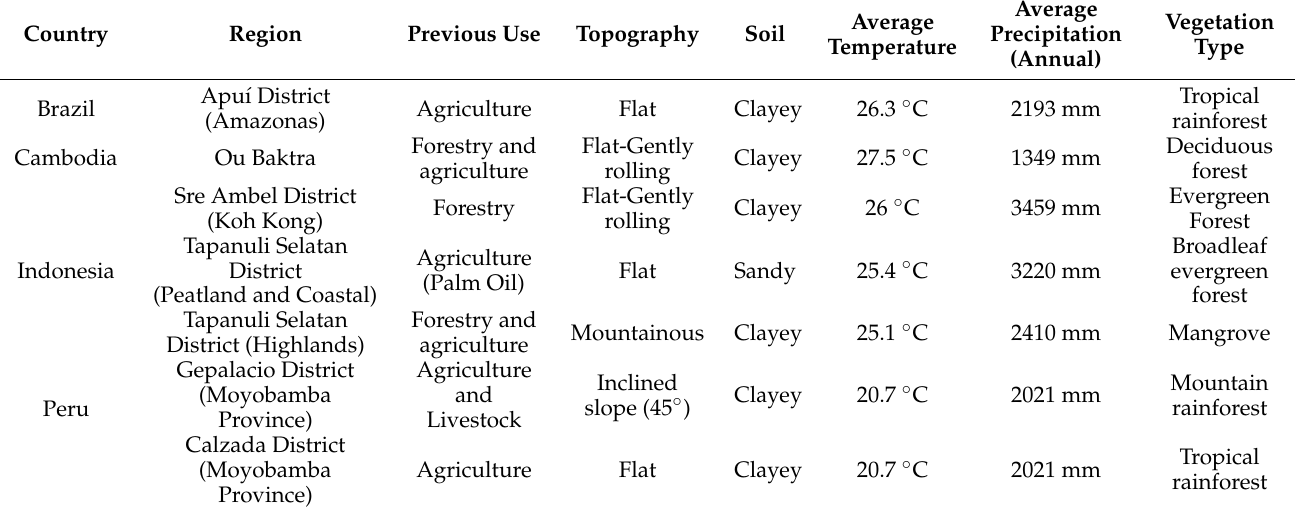
Table 1. Biophysical characteristics of studied areas.